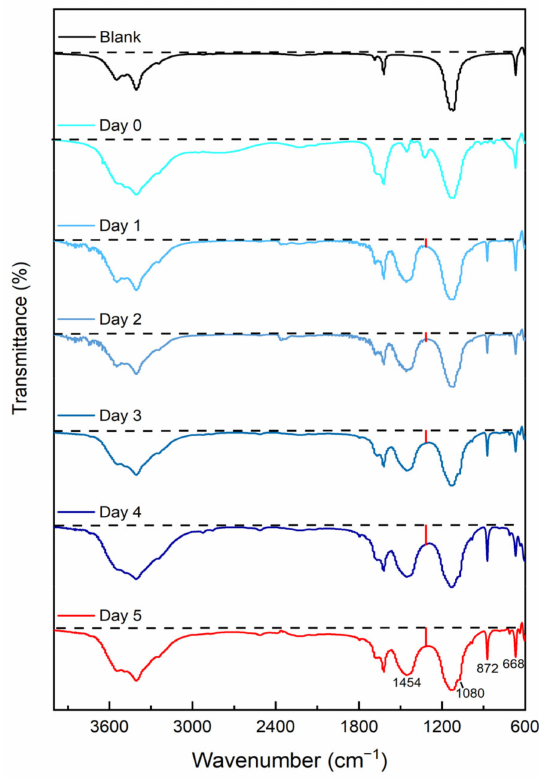
Figure 6. FTIR spectra of the specimens at different time